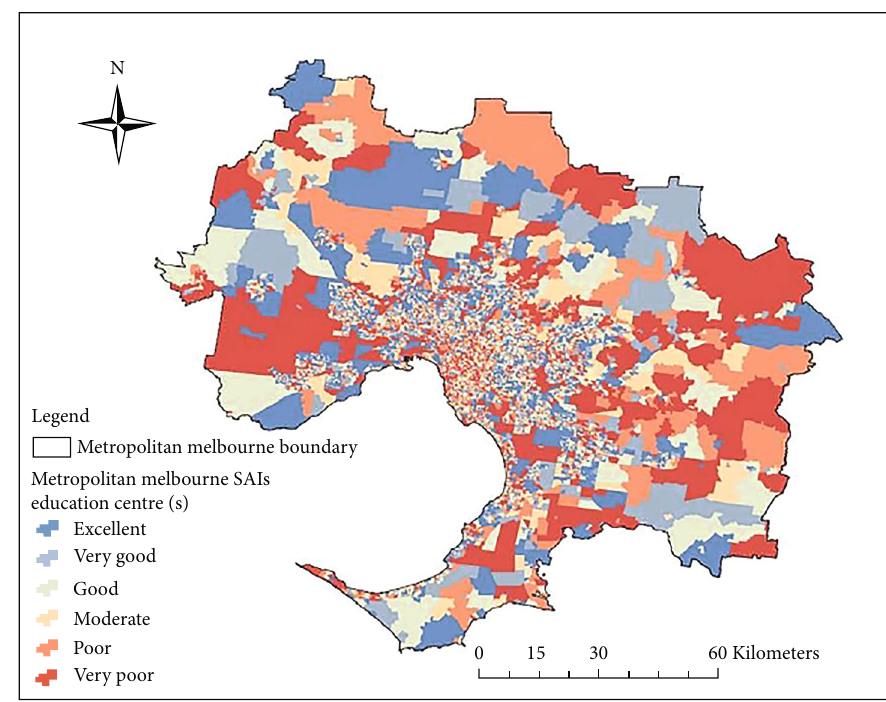
Figure 4: Older people public transport accessibility index for education centre(s) (https://desktop.arcgis.com/en/arcmap/latest)